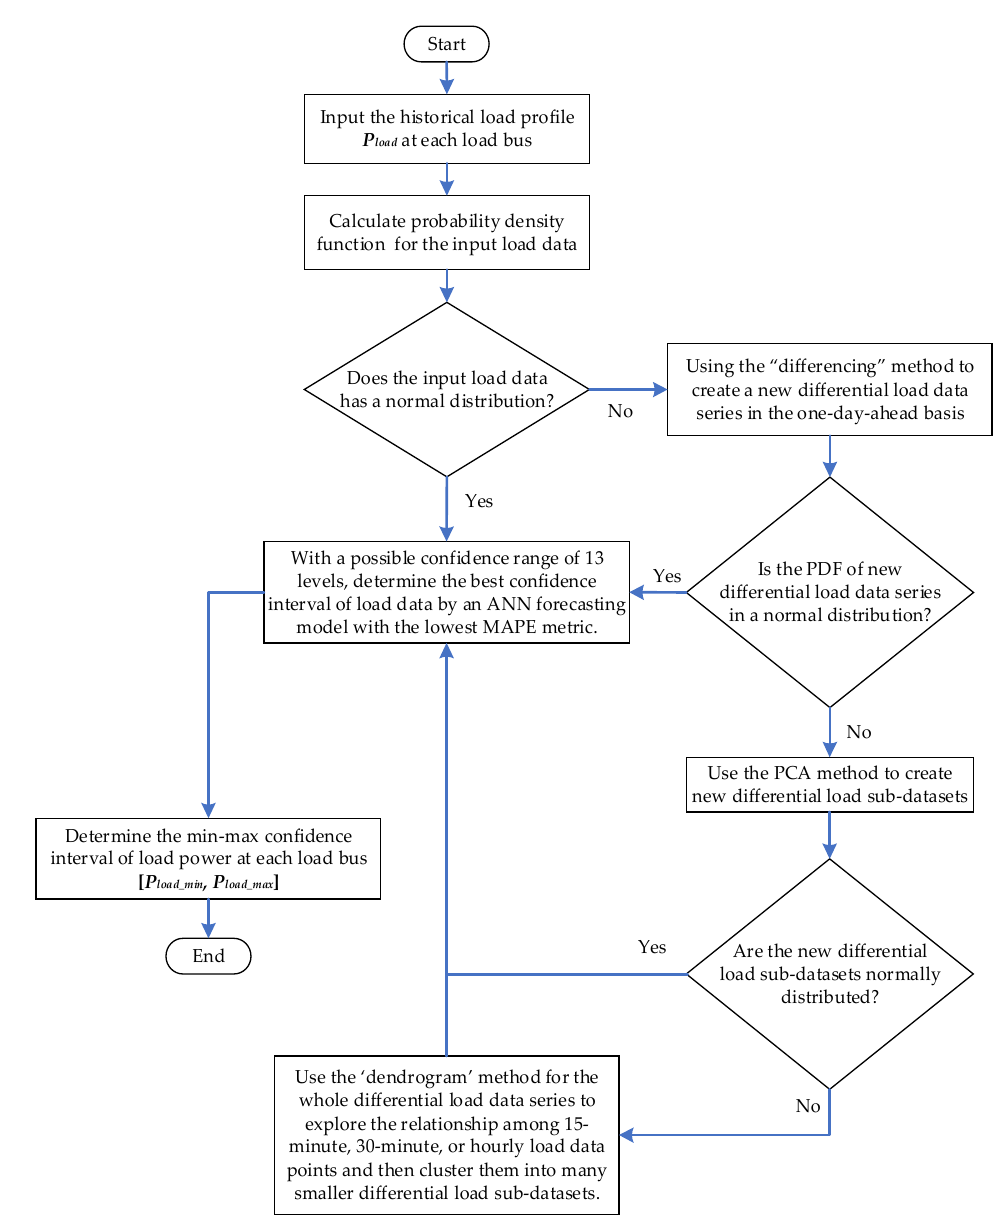
Figure 2. A flow diagram of forecasting a min-max confidence interval of load power at each load bus in the DN.